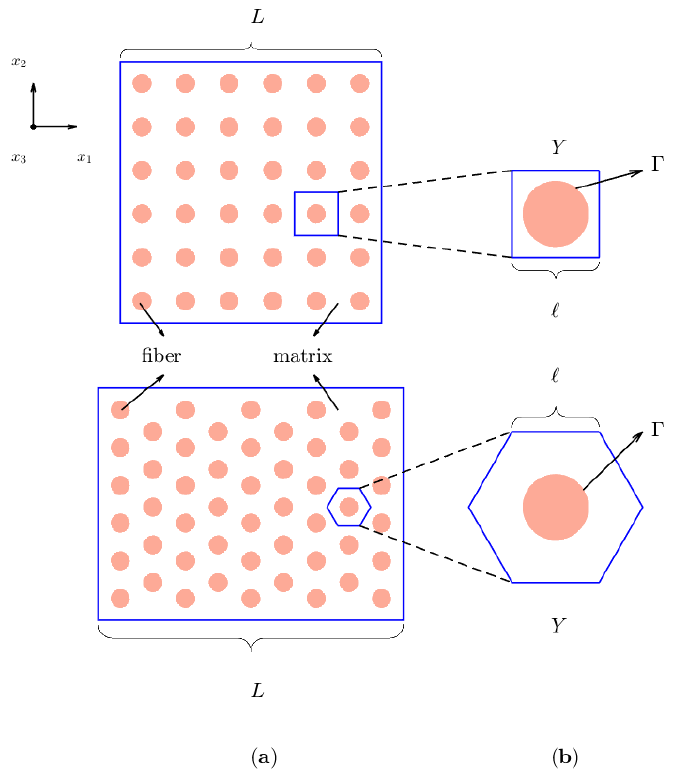
Figure 1. Fiber distribution for square (up) and hexagonal (down) cells. ( a ) Cross section of a cylindrical fiber reinforced composite along the x 3 direction. ( b ) Representative cell Y